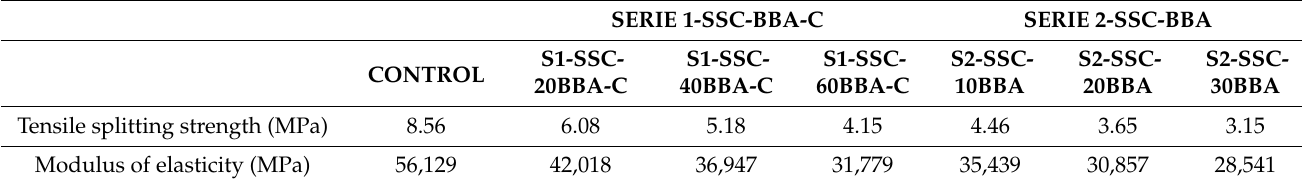
Table 6. Tensile splitting strength and modulus of elasticity.